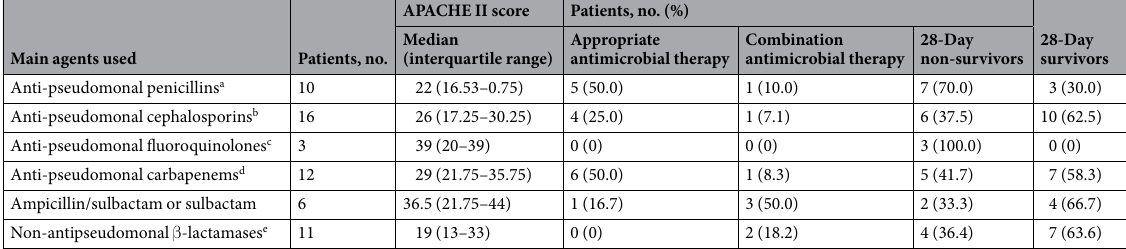
Table 3. Antimicrobials usage and the 28-day survival rates in patients with bacteraemic pneumonia caused by biofilm-forming Acinetobacter baumannii . * Data are the median (interquartile range) for continuous variables and number of cases (%) for categorical variables. APACHE II = Acute Physiologic and Chronic Health Evaluation II. a Piperacillin, piperacillin/tazobactam and ticarcillin/clavulanate. b Cefoperazone, ceftazidime, cefepime and cefpirome. c Ciprofloxacin and levofloxacin. d Imipenem and meropenem. e Penicillin, amoxicillin/